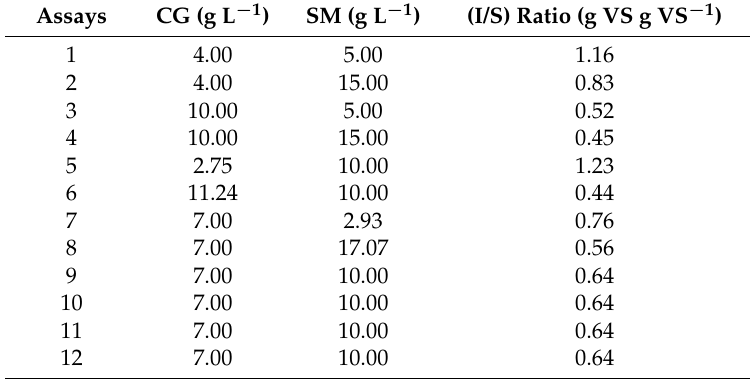
Table 8. Concentrations of CG and SM assigned by the central composite design, used as planning for the anaerobic assays.